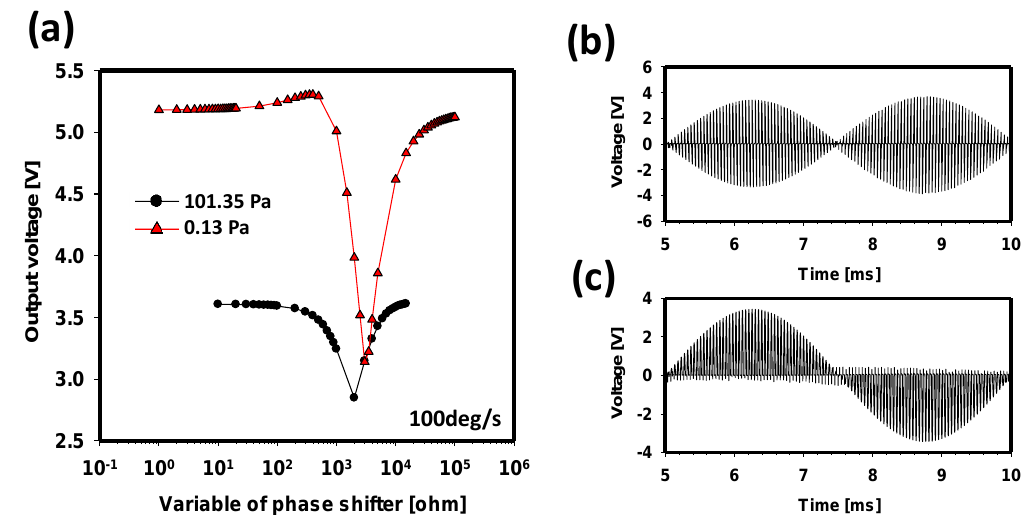
Figure 8. ( a ) Output voltage (angular–rate signal) as a function of the resistance of the phase shifter in response to 100°/s. ( b ) Demodulated signal using a phase shifter with 3 kΩ. ( c ) Demodulated signal using a phase shifter with 560 Ω.